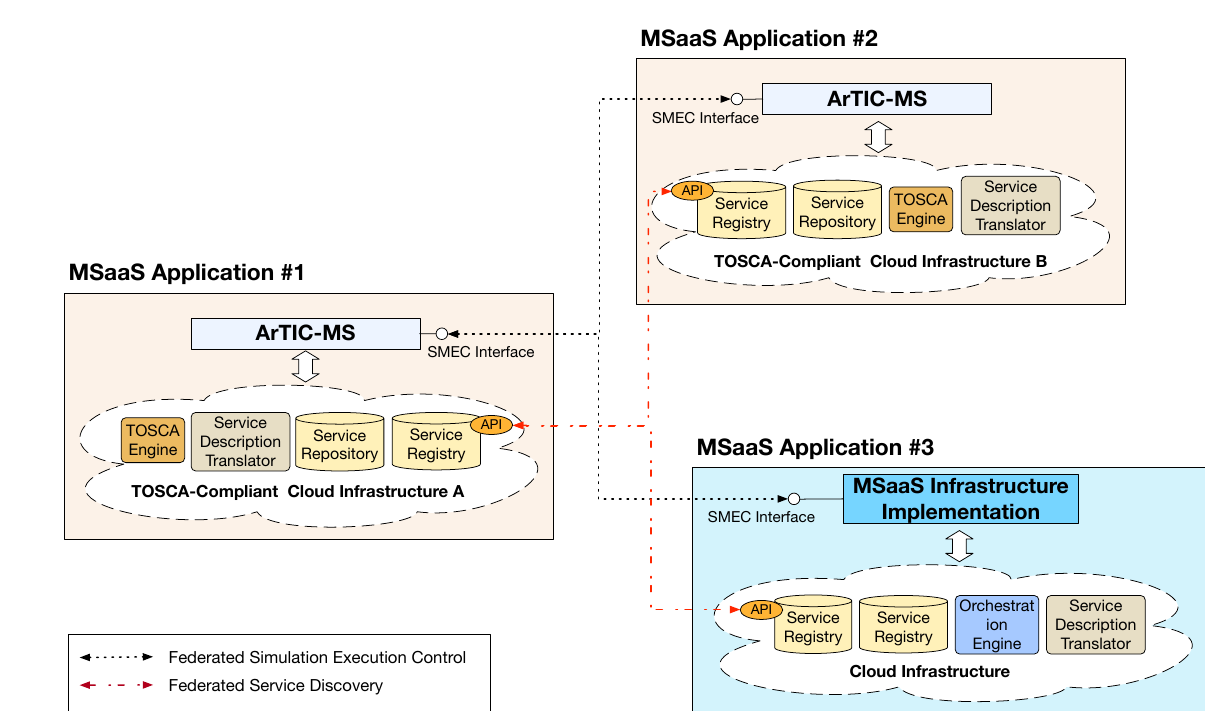
Figure 6. Federated MSaaS